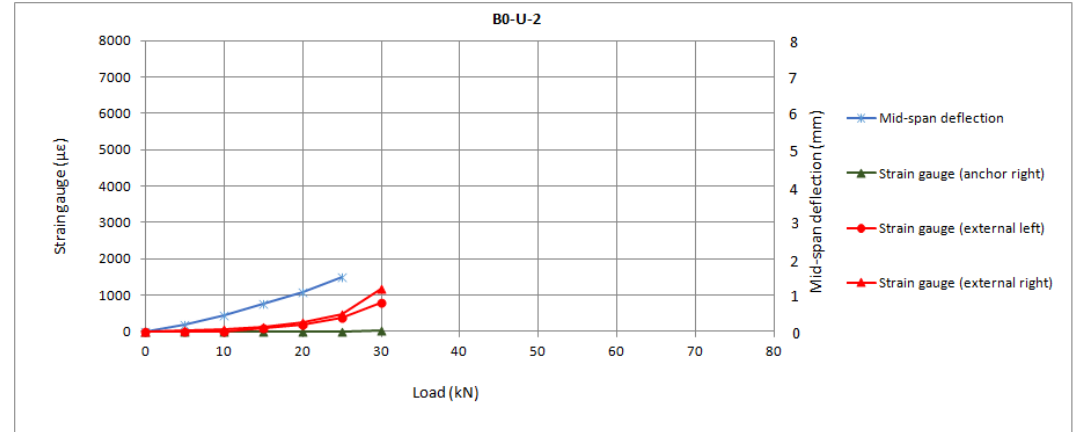
Figure 9. Load-slip response of the U series.